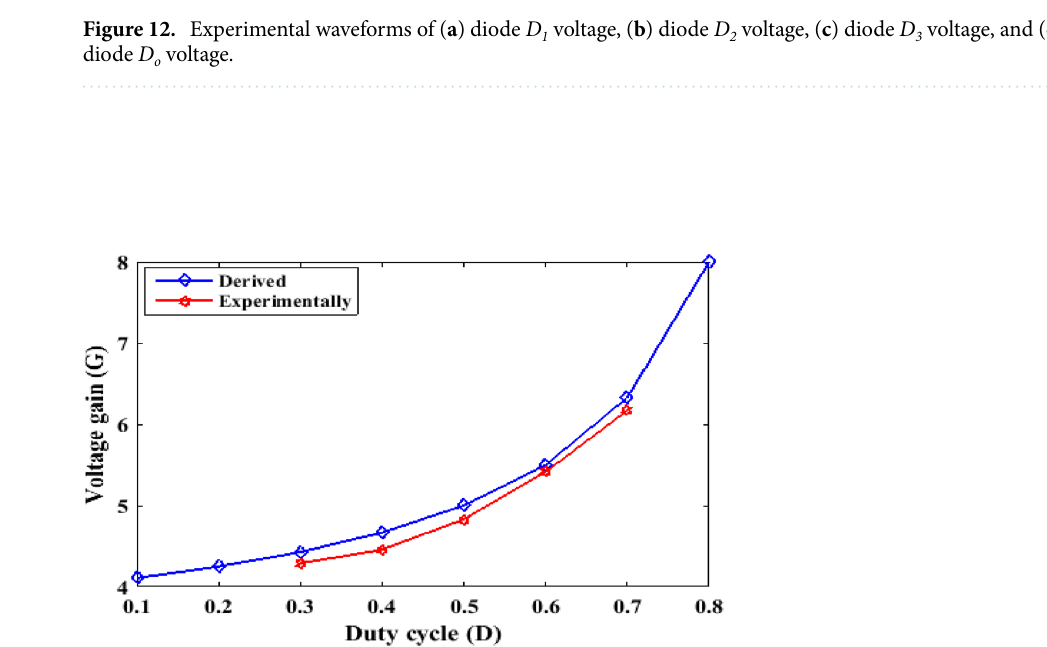
Figure 13. Voltage gain versus duty cycle: derived and